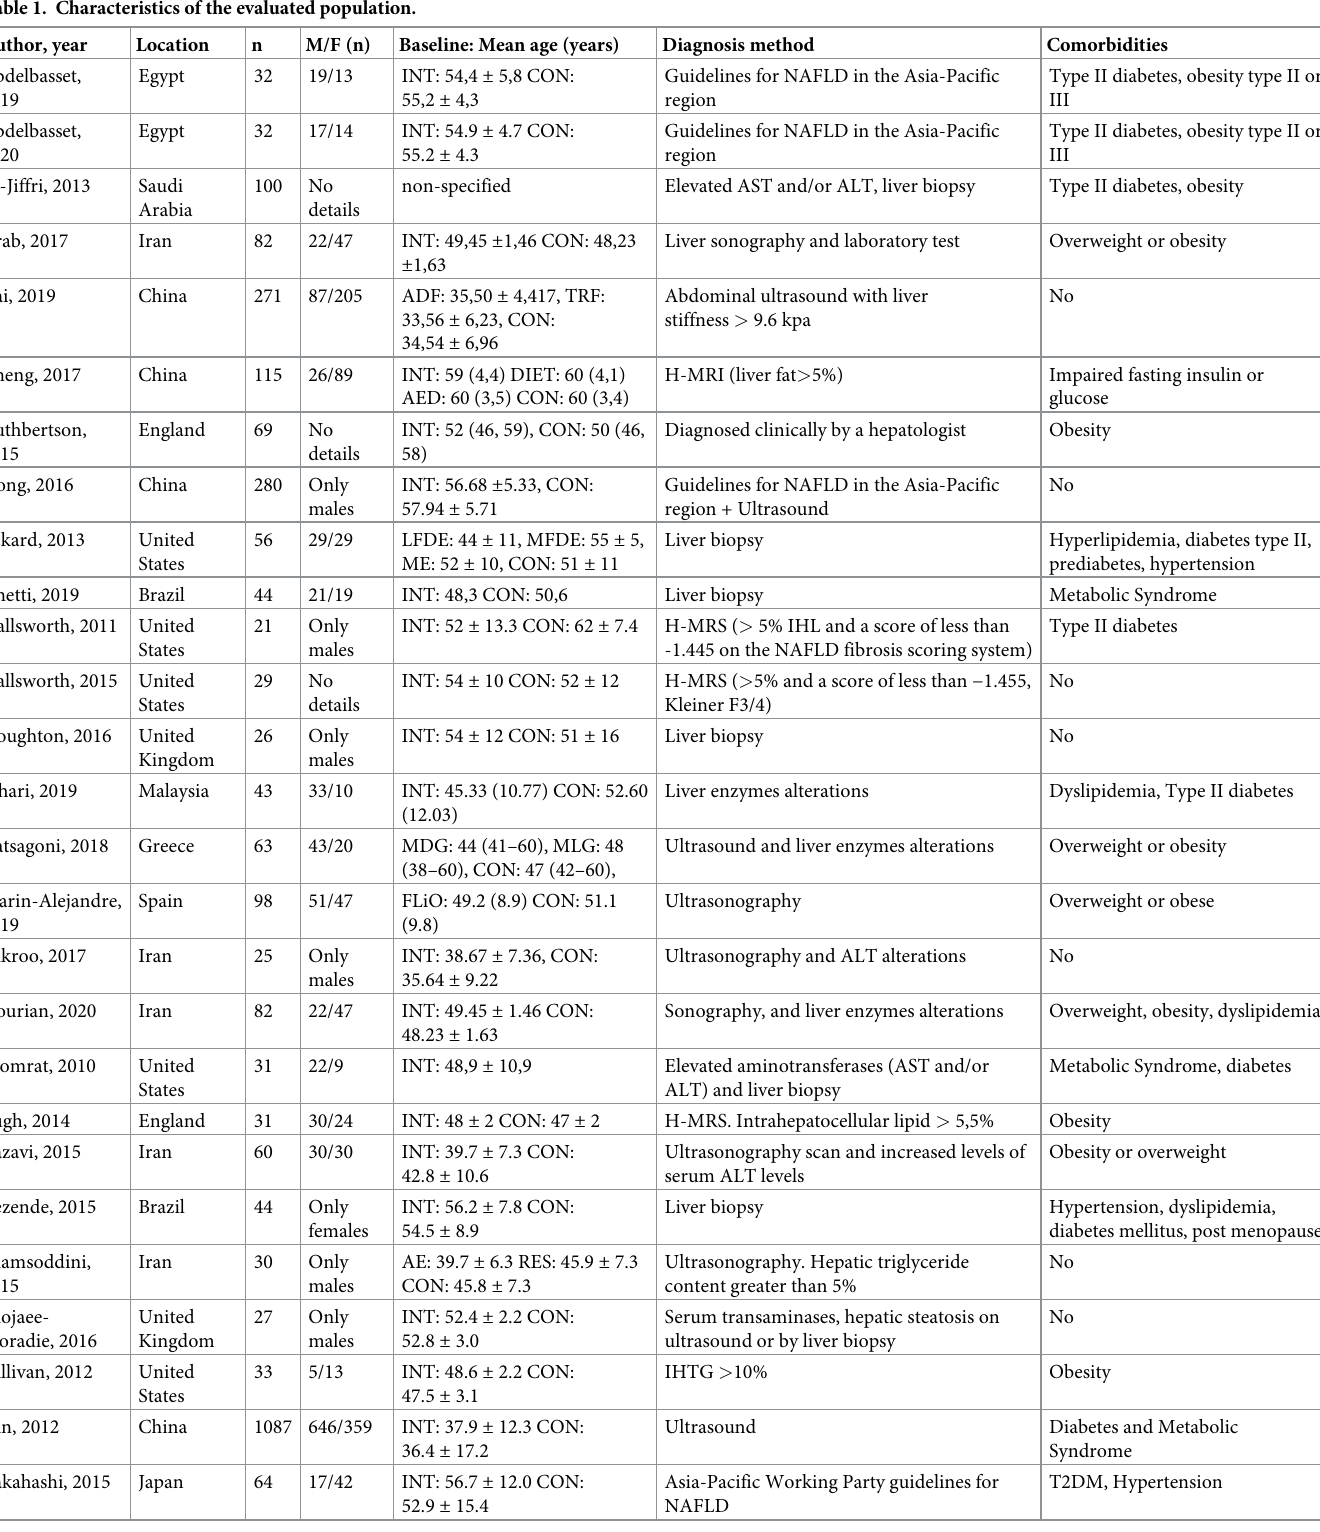
Table 1. Characteristics of the evaluated